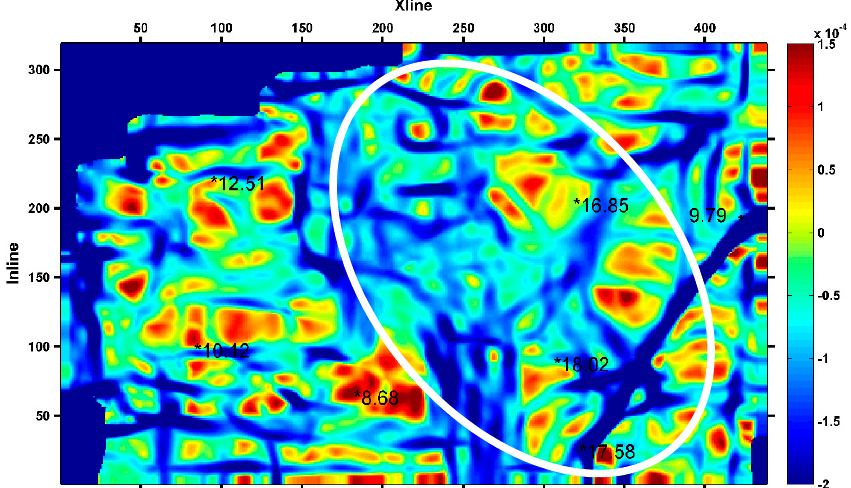
Figure 18. Negative curvatures curvature of 3# coal seam.